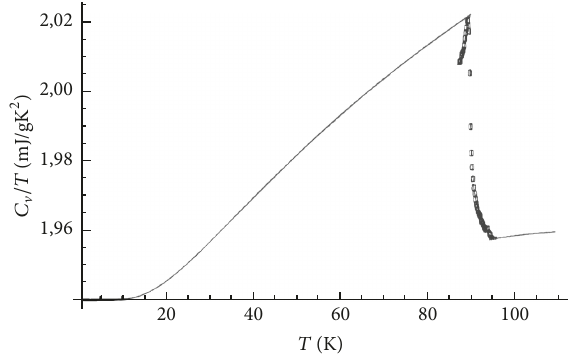
Figure 6: Comparison of the theoretical (solid line) and experimen- tal [29] (broken line) dependencies in the region of the heat capacity